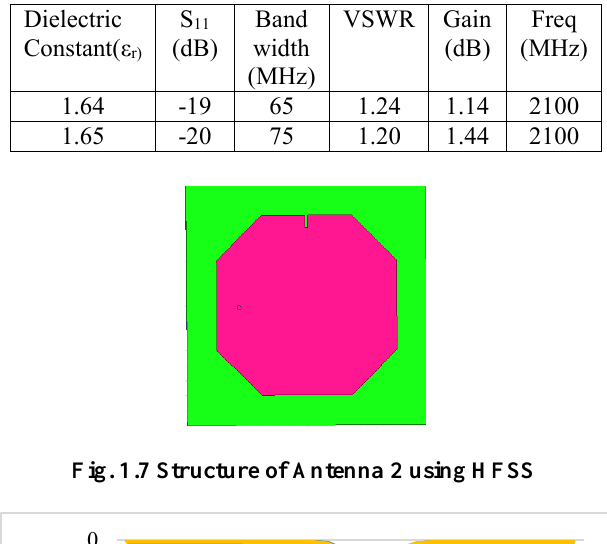
Table 1.2 Analysis of different parameters for Antenna 2